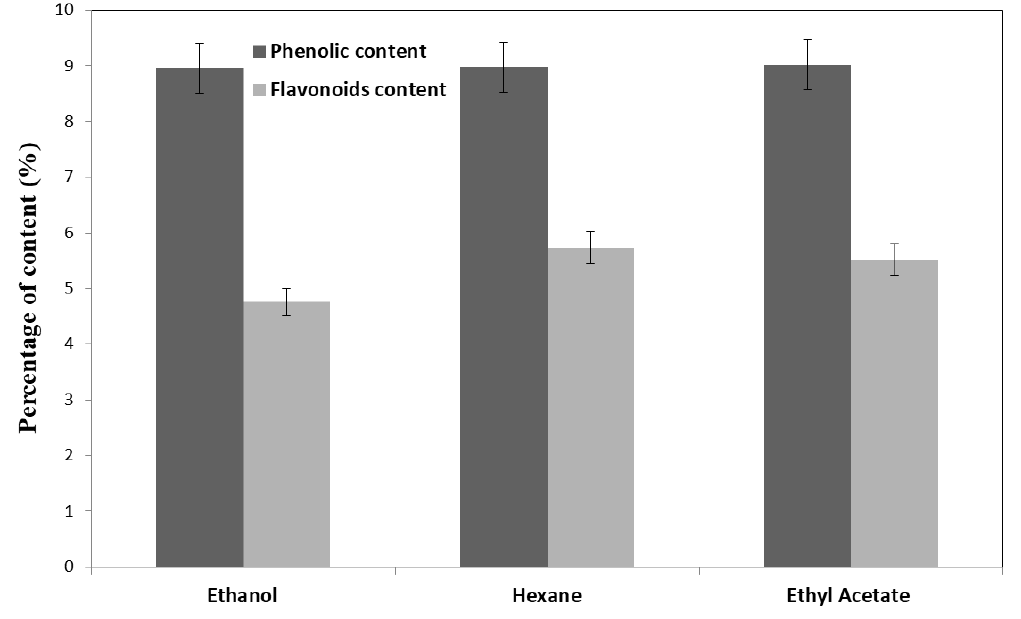
Figure 3. Total phenol and flavonoid content (%) of ethanolic, hexanolic, and ethyl acetate Echinops spinosissimus extracts. spinosissimus